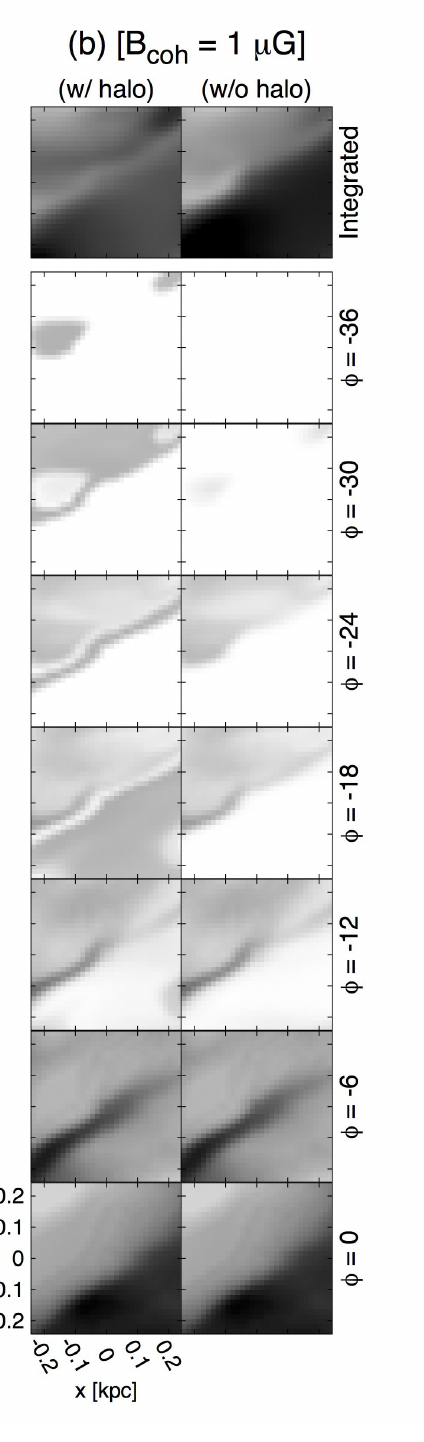
Figure 4. Normalized, absolute polarization intensity ( | P | ) images. Left two columns show results from the “ B coh = 0” case ( a ) and right two columns show results from the “ B coh = 1 µ G” case ( b ). In each case, the left column shows the “with halo” case and right column shows “without halo” case. Top panels show the LOS-integrated images. Panels from the second top show slice images from the Faraday depth cube at different Faraday depth, φ . The unit of φ is in rad m − 2